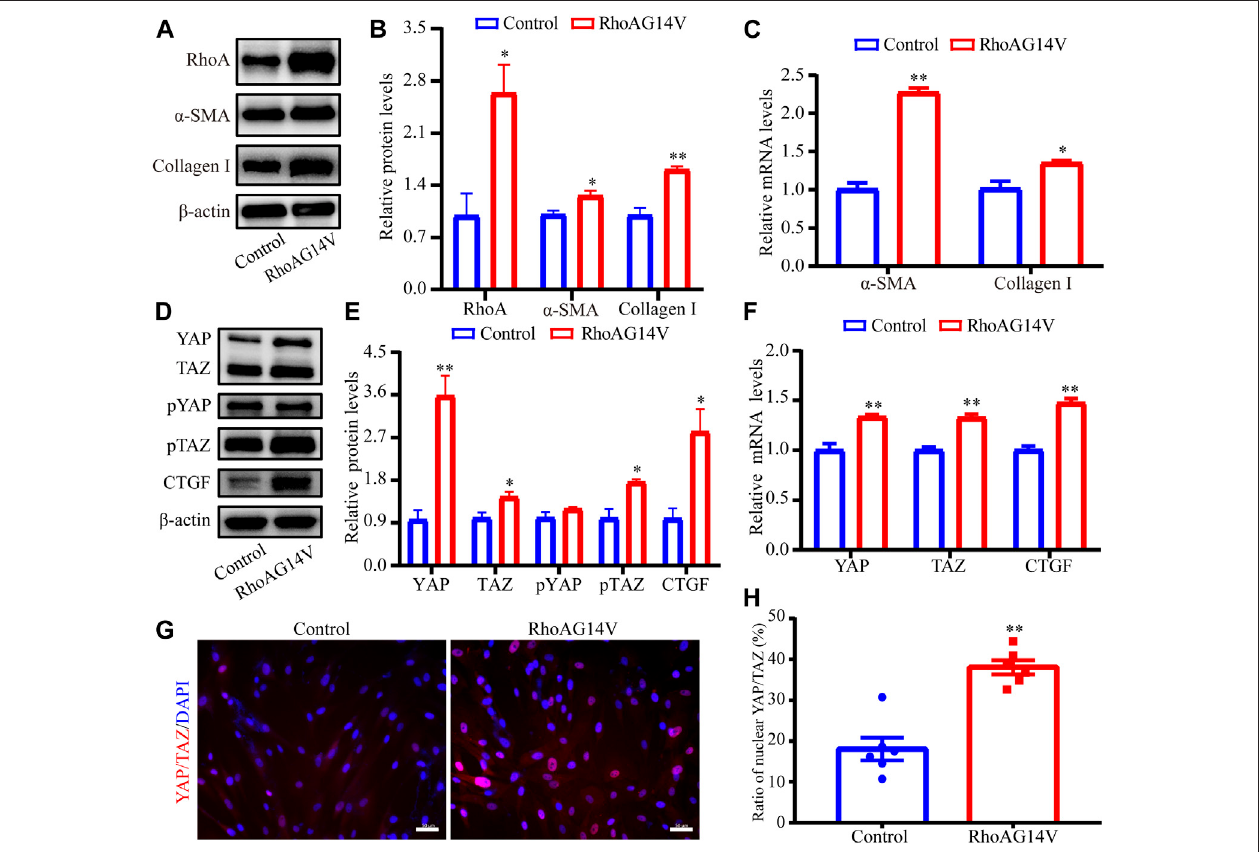
FIGURE 7 | RhoAG14V promoted the expression of Collagen I and α -SMA and regulated YAP/TAZ in HTM cells (A) The bands of RhoA, α -SMA, and Collagen I proteins (B) Quanti fi cation analyses of RhoA, α -SMA, and Collagen I expression levels (C) RT-qPCR analyses of α -SMA and Collagen I mRNAs (D) The bands of YAP/ TAZ,pYAP,pTAZ,andCTGFproteins (E) Quanti fi cationanalysesofYAP,TAZ,pYAP,pTAZ,andCTGFproteins (F) RT-qPCRanalysesofYAP,TAZ,andCTGFmRNAs (G) Representative fl uorescent graphs of YAP/TAZ labeled by speci fi c antibody and (H) quantitative analysis of YAP/TAZ in the nucleus. Scale bar, 50 μ m; * p < 0.05; ** p <